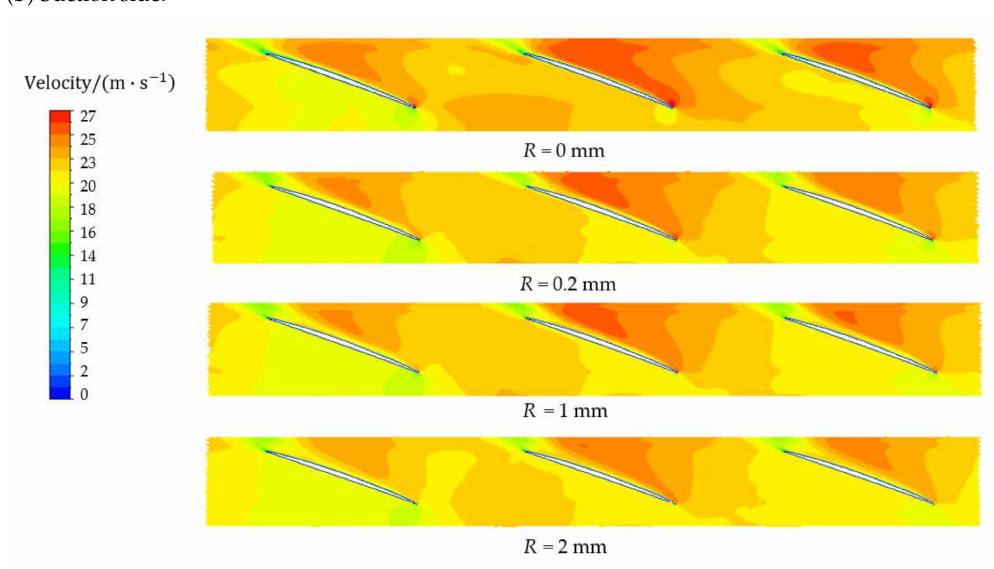
Figure 20. Cylindrical distribution of impeller internal velocity under turbine condition ( r ∗ =